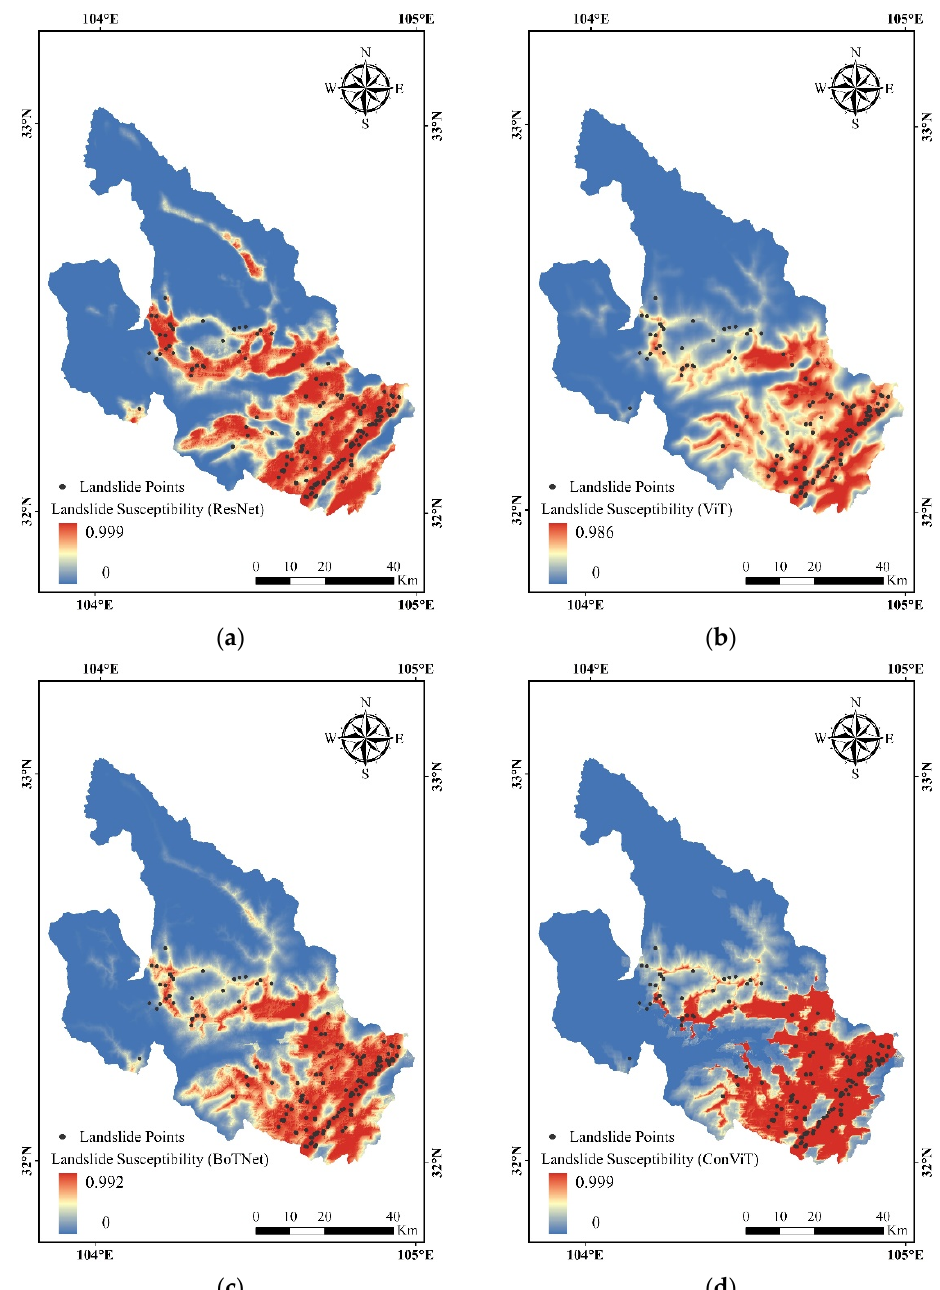
Figure 9. Landslide susceptibility mapping by ( a ) ResNet, ( b ) ViT, ( c ) BoTNet and ( d ) ConViT.